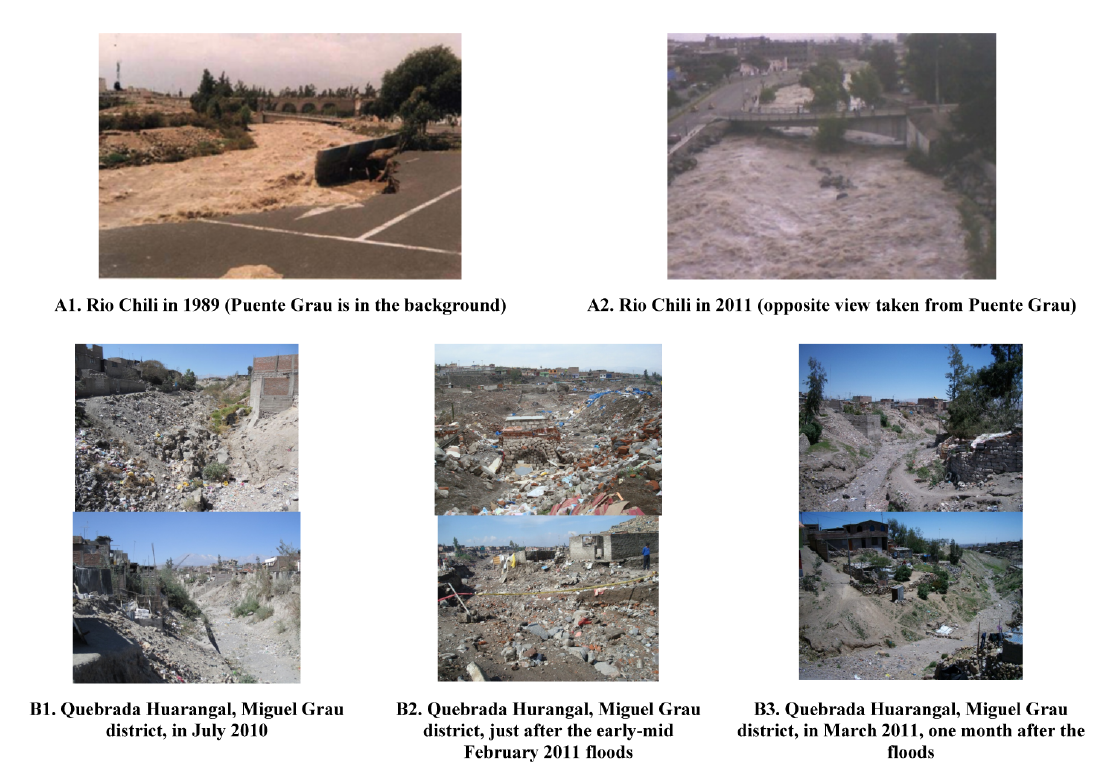
Fig. 3. Pictures showing the R´ıo Chili valley near the city centre (Puente Grau) and Qda. Huarangal in Arequipa (own work). The location of pictures (A) and (B) is provided in Fig.